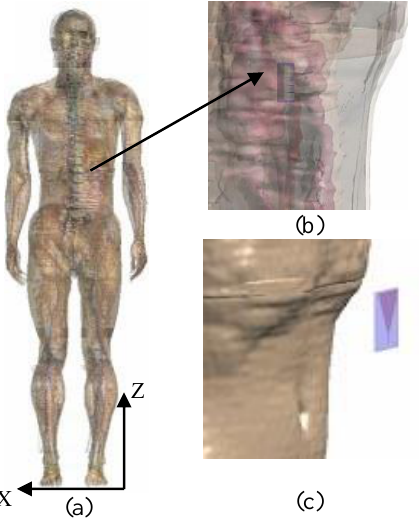
Figure 3. (a) Duke anatomical model. (b) Ingestible antenna inside the small intestine of the anatomical model. (c) On-body antenna placed 15 mm from the abdomen of the anatomical